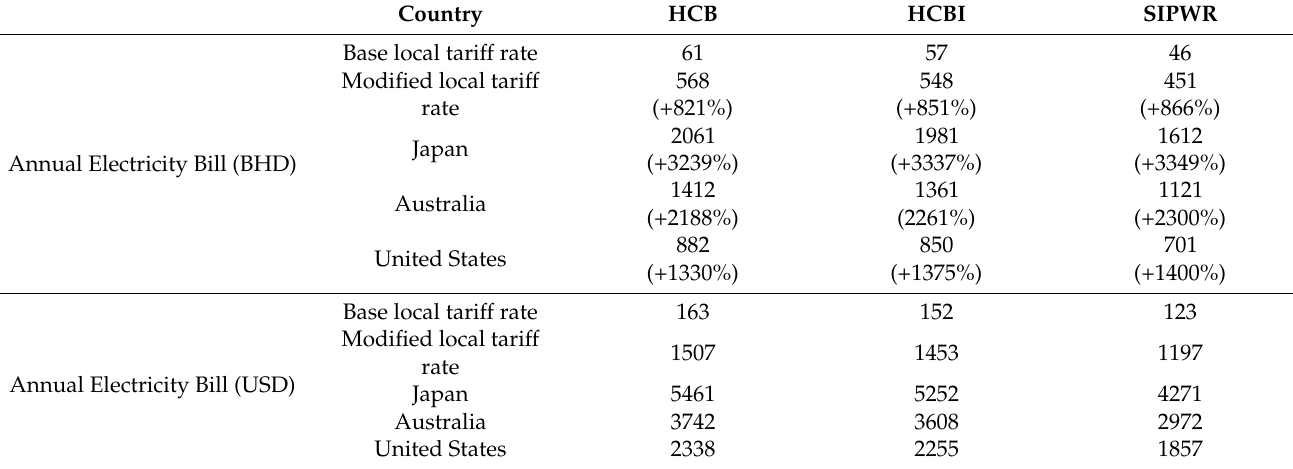
Table 9. Annual electricity bills across different countries for the Hollow Core Block (HCB), Hollow Core Block-Insulated (HCBI) and the Structural Insulated Panel Wall (SIPWR) house types, in Bahraini dinars (BHD) and United States Dollars